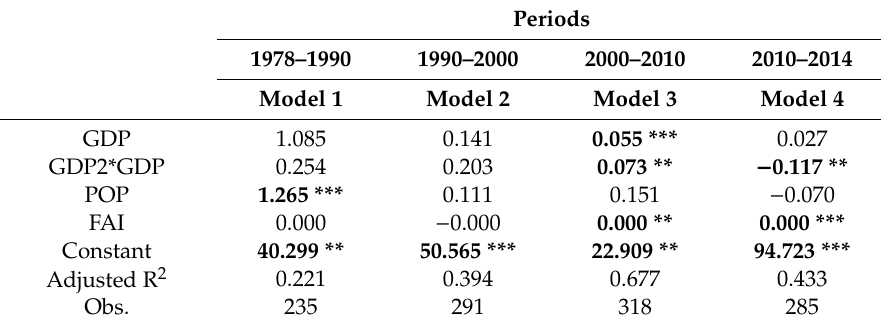
Table 6. Results of linear OLS